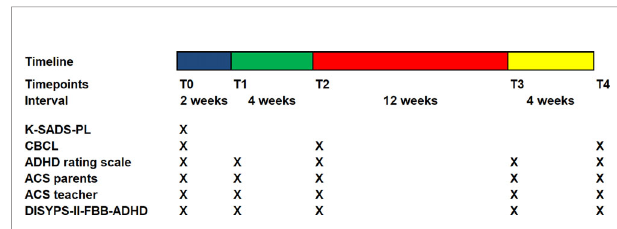
FIGURE 1 | Timescales and measures for each appointment. Blue bar: pre- diet phase (2 weeks), normal eating. Green bar: diet phase (4 weeks). Red and yellow bar: reintroduction phase (6 + 10 weeks). T0: Baseline and beginning of documentation, T1: Start of OD, T2: Start of reintroduction phase, T3: 6 weeks after start of reintroduction, T4: after completion of